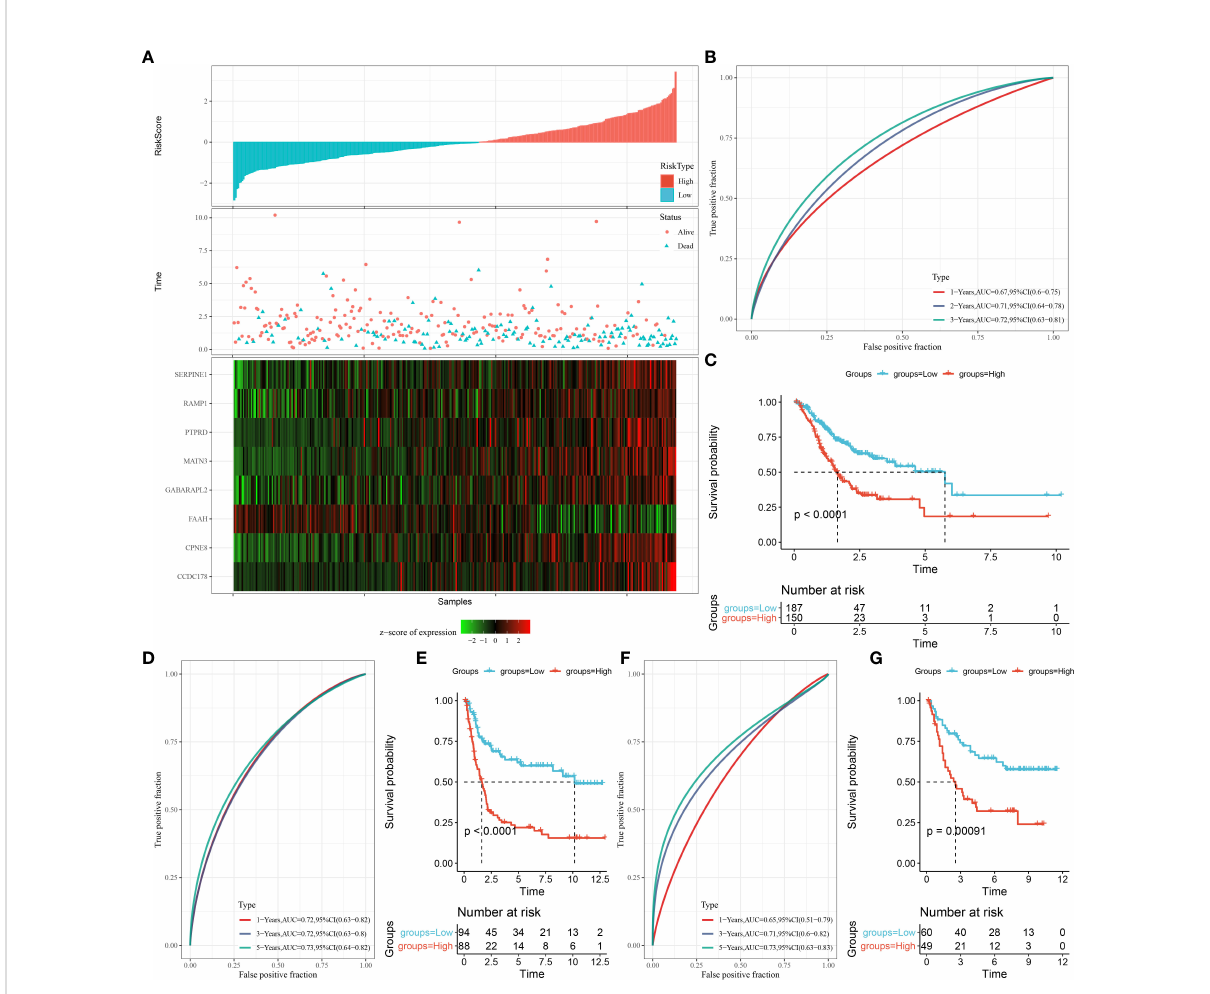
FIGURE 7 The construction of OSRG-based prognostic signature in the TCGA cohort. (A) The distribution of patient longevity status and risk score, and the expression pro fi les of nine aging genes in high and low risk group in TGGA cohort. (B, D, F) represent the receiver operating characteristic curves for forecasting overall survival in the TCGA cohort, GSE21257, and GSE16091 cohort, respectively. (C, E, G) represent the survival curves for patients with high risk score and low risk score in TCGA